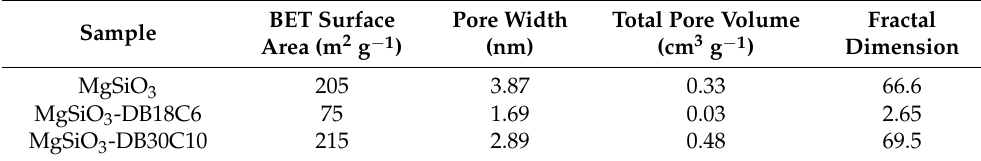
Table 1. Textural parameters calculated from N 2 adsorption